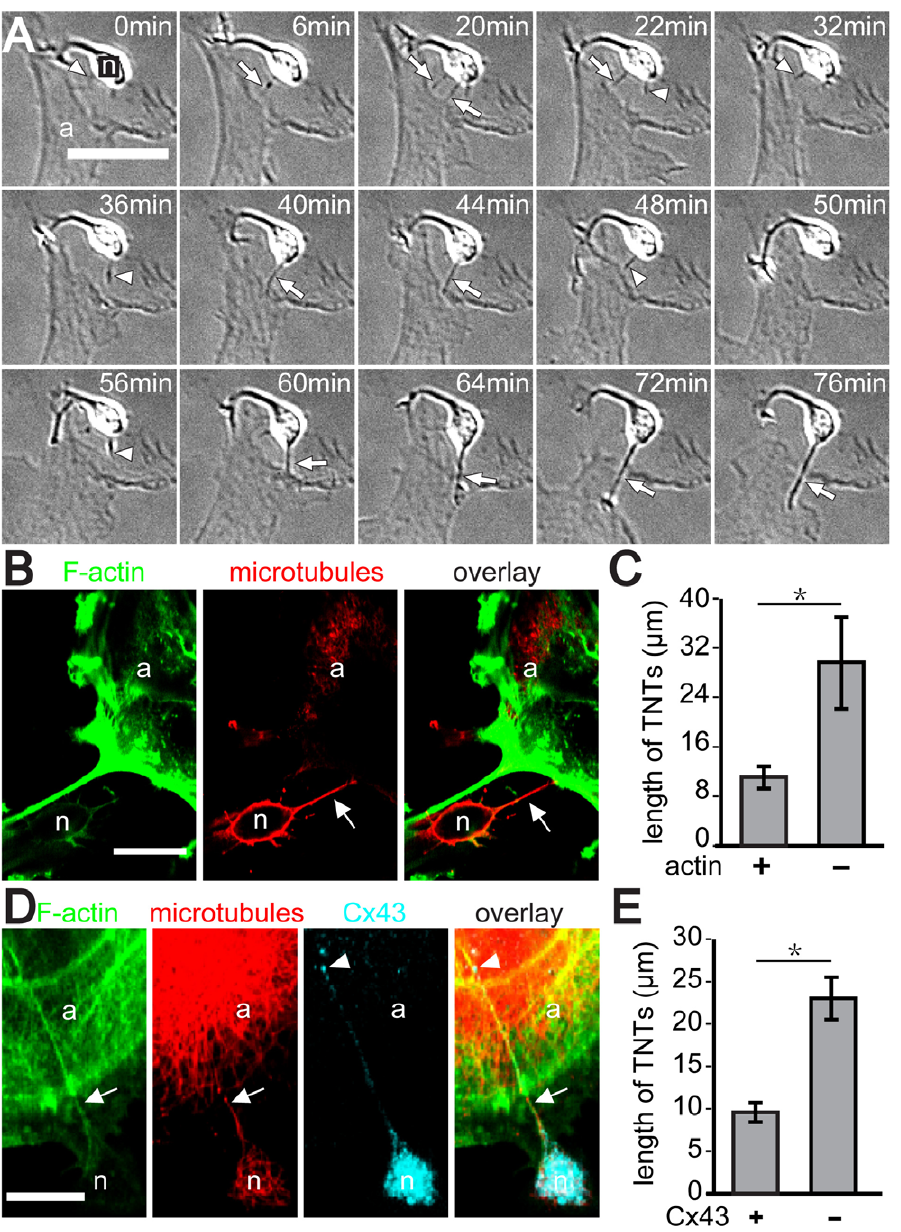
Figure 1. Formation of TNT-like structures between neurons and astrocytes. ( A ) Neurons form tubular extensions that connect to astrocytes. Astrocytes were co-cultured with freshly prepared dissociated hippocampal neurons and imaged by DIC microscopy 2 hours later. Shown are selected time frames depicting the formation of TNT-like structures ( arrows ) between a neuron (‘‘n’’) and an astrocyte (‘‘a’’). Note that the neuron displays tubular extensions before TNT formation and after their breakage ( arrowheads ). ( B ) A portion of TNT-like structures is microtubules positive but deficient in F-actin. The confocal fluorescence images depict a TNT ( arrow ) between neuron (‘‘n’’) and astrocyte (‘‘a’’), which contains microtubules ( middle ) but no F-actin ( left ). ( C ) TNTs positive for F-actin are shorter than those lacking F-actin. ( D ) TNT-like structures display Cx43 immunofluorescence signals. Neurons and astrocytes were co-cultured for 5 hours, fixed and fluorescently labeled using phalloidin-Alexa Fluor ( green ) and antibodies against a -tubulin ( red ) and Cx43 ( cyan ). The confocal image shows a typical TNT ( arrow ) formed between a neuron (‘‘n’’) and an astrocyte (‘‘a’’). Note the F-actin and microtubule staining of the TNT along with punctate Cx43 immunofluorescence signals at the astrocyte-neuron contact site ( arrowhead ). ( E ) TNTs positive for Cx43 are shorter than those lacking Cx43. The graphs represent a statistical analysis of 20 TNT structures (C and E). Data were analyzed by student’s two-tailed t-test. Error bars show mean 6 SEM. Scale bars=20 m m. doi:10.1371/journal.pone.0047429.g001 In parallel, neuronal differentiation was analyzed using the neurons were positive for tau-1, whereas after 24 hours the vast antibody against tau-1. Cx43 was strongly expressed by most majority of them displayed a strong tau-1 staining in soma and neurons after 5 hours of co-culturing but was absent in nearly all dendrites (Figure 4A). A detailed analysis revealed that 88% of the cells after 24 hours (Figure 4A). In contrast, after 5 hours only few neurons (n= 68) were Cx43 positive after 5 hours and of these only